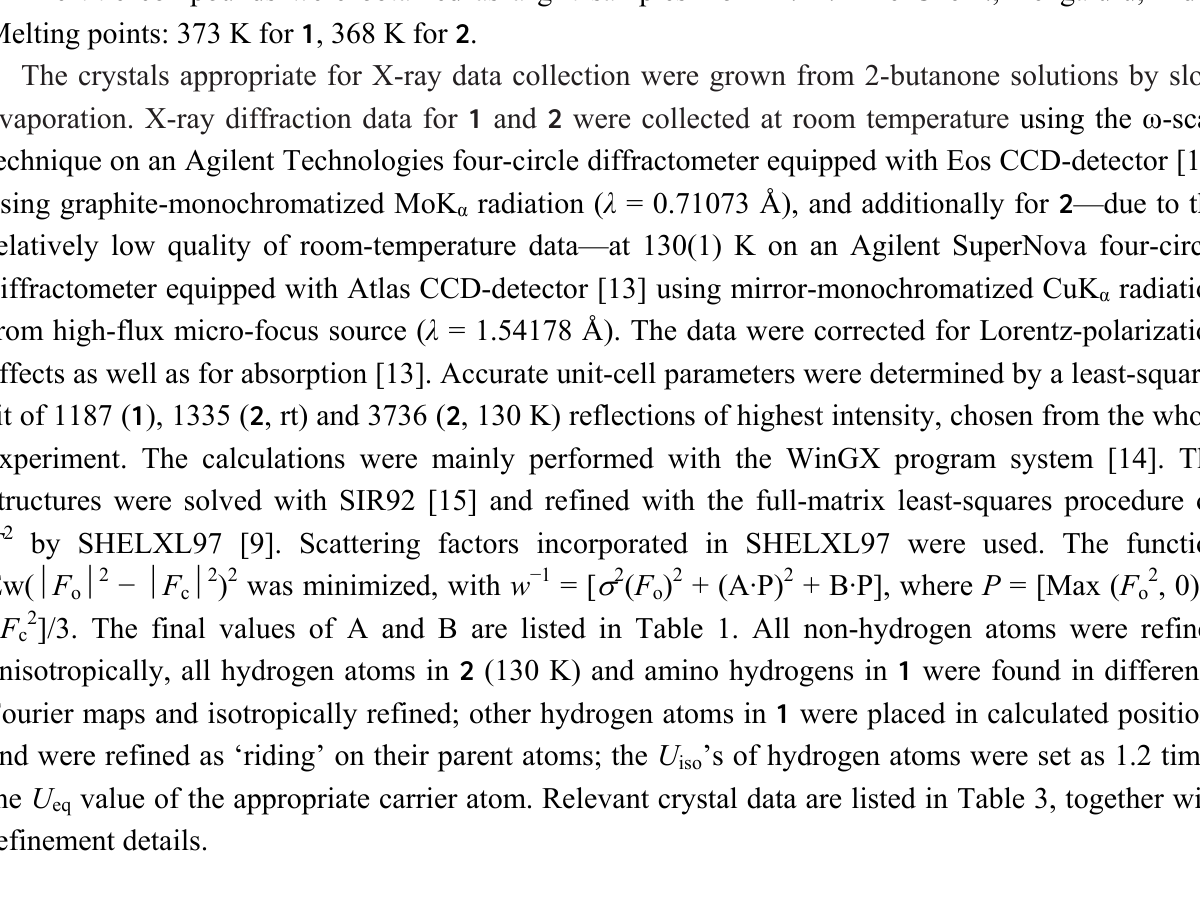
Table 3. Crystal data and refinement